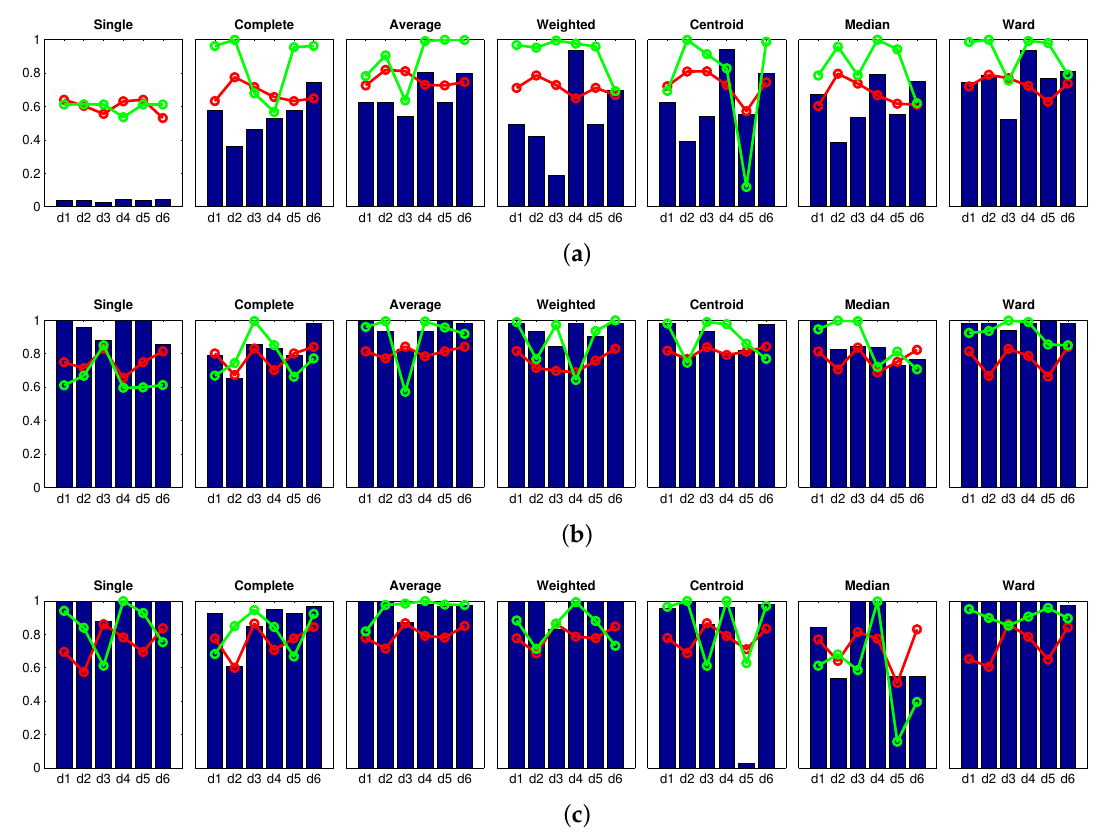
Figure 8. Legend: (cid:4) Accuracy c ; −◦− Correlation γ coph ; −◦− Inconsistency δ inconsist . Results of the high-level clustering using HOG (Histogram of Oriented Gradients) as global-appearance descriptor and ( a ) k 4 = 1; ( b ) k 4 = 4; and ( c ) k 4 =